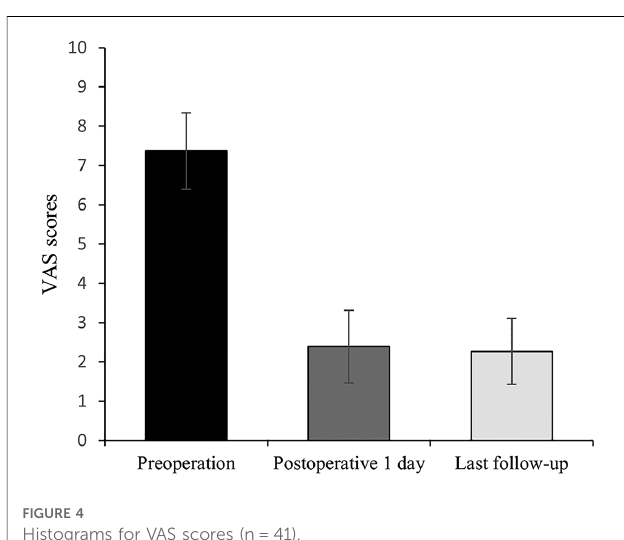
FIGURE 4 Histograms for VAS scores